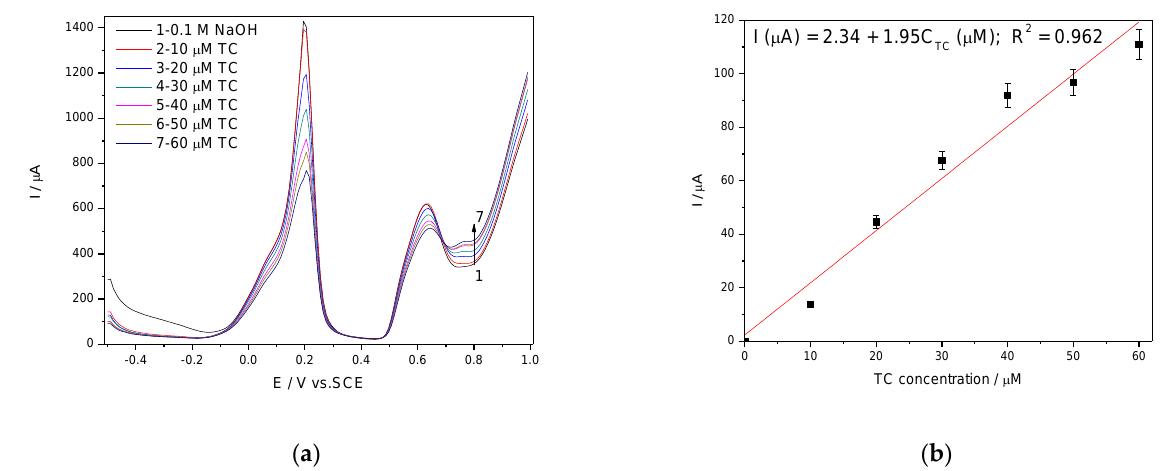
Figure 10. ( a ) Square-wave voltammetry (SWV) recorded on a Ag/GO/BDD in 0.1 M NaOH supporting electrolyte under optimized conditions at a frequency of 10 Hz, step potential (SP) 10 mV and modulation amplitude (MA) 200 mV in the potential range of − 0.500 to +1.00 V vs. SCE in the presence of 10-60 µM TC concentration; ( b ) The calibration plots of the currents recorded at recorded at E = +0.766 V/SCE versus TC concentrations.